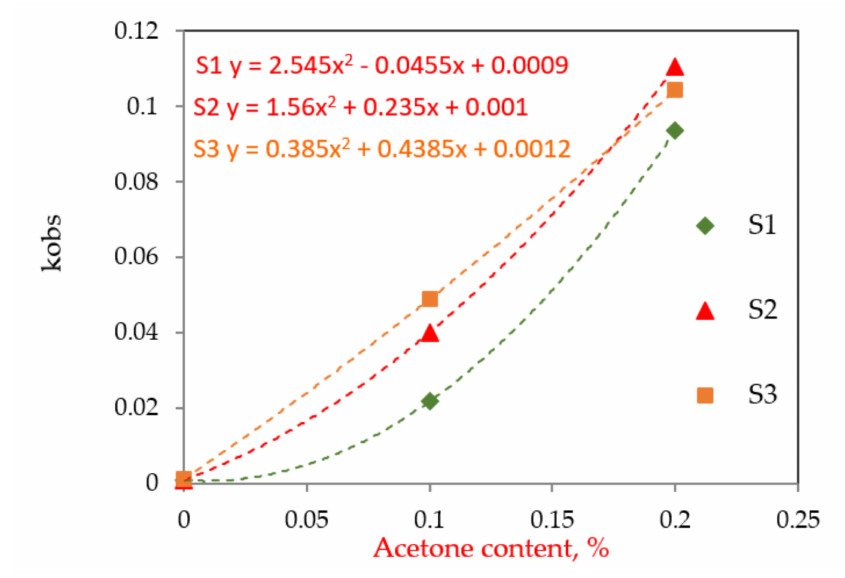
Figure 10. Influence of acetone concentration over reaction